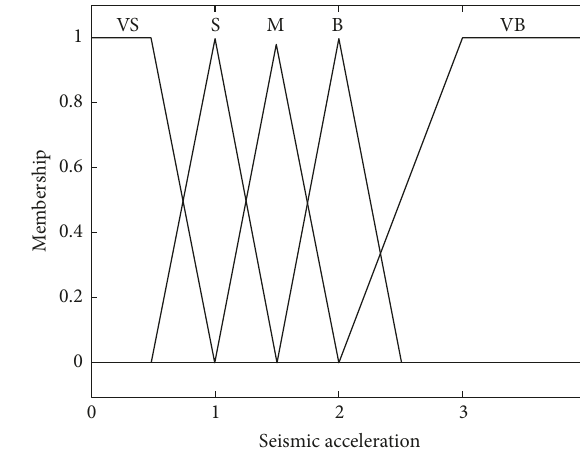
Figure 9: Seismic acceleration membership function curve.